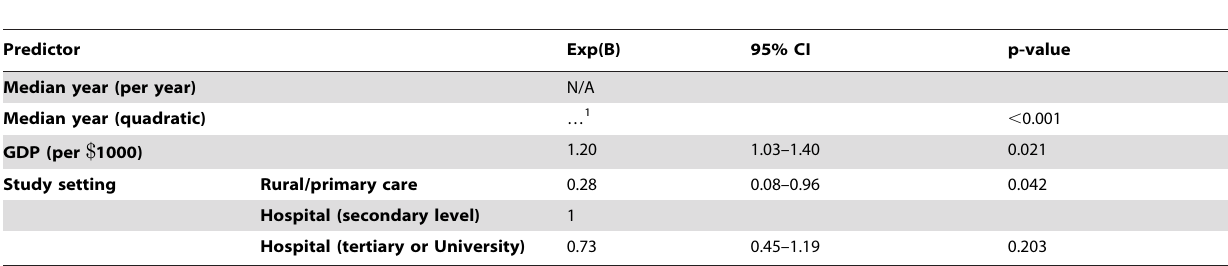
Table 5. Results of analysis of predictors of PCP via logistic regression for 18 African adult clinical respiratory studies.